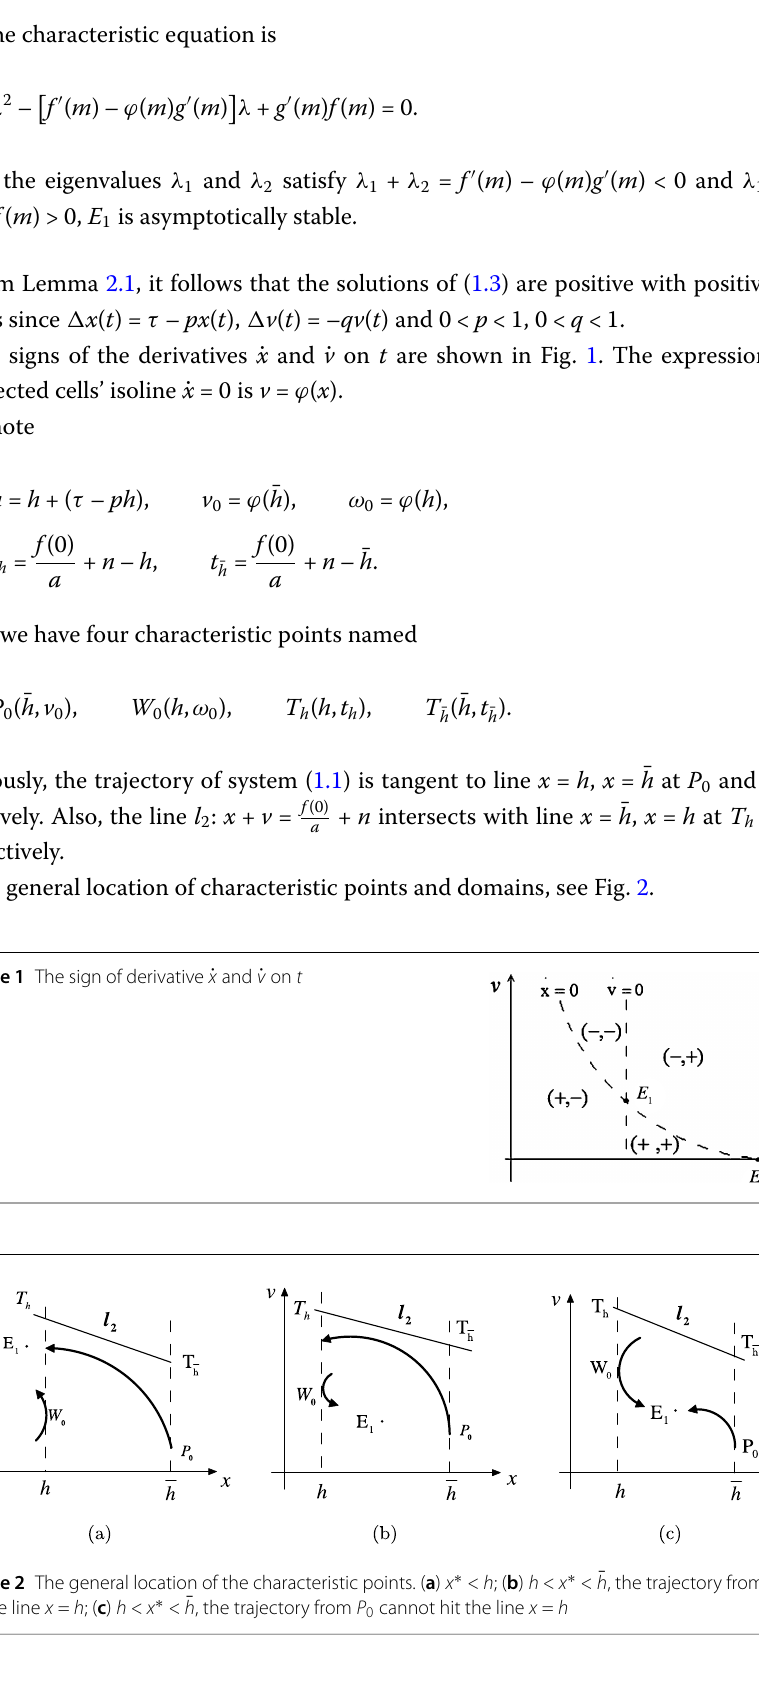
Figure 2 The general location of the characteristic points. ( a ) x ∗ < h ; ( b ) h < x ∗ < ¯ h , the trajectory from P 0 can hit the line x = h ; ( c ) h < x ∗ < ¯ h , the trajectory from P 0 cannot hit the line x =